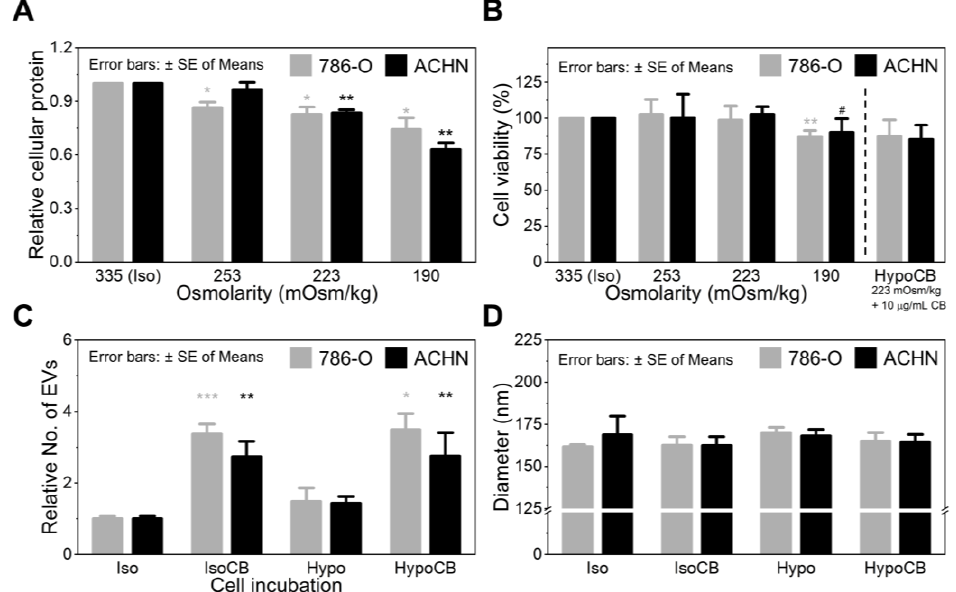
Figure 3. The effect of hypo-osmotic pressure on ( A ) amount of total cellular protein ( n = 8), ( B ) cell viability ( n = 4), ( C ) EV production ( n ≥ 3), and ( D ) size of the produced EVs ( n ≥ 3). Significance levels are indicated as # p < 0.10, * p < 0.05, ** p < 0.01, and *** p < 0.001, compared to the non-CB treated cells.